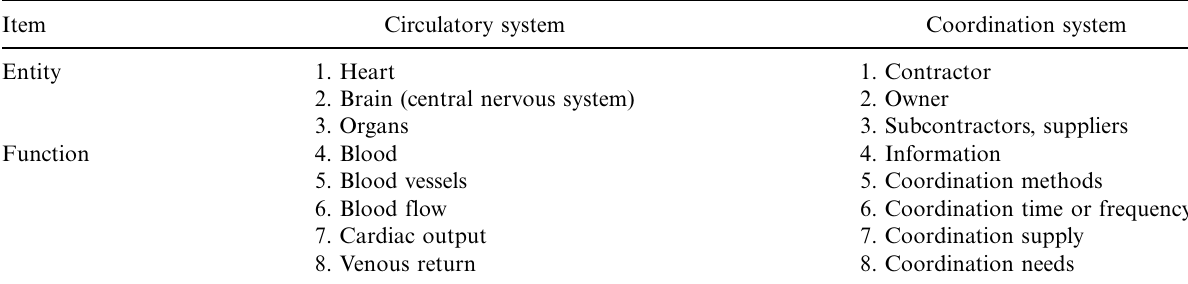
Table 1. Entity and function comparisons between coordination system and circulatory system